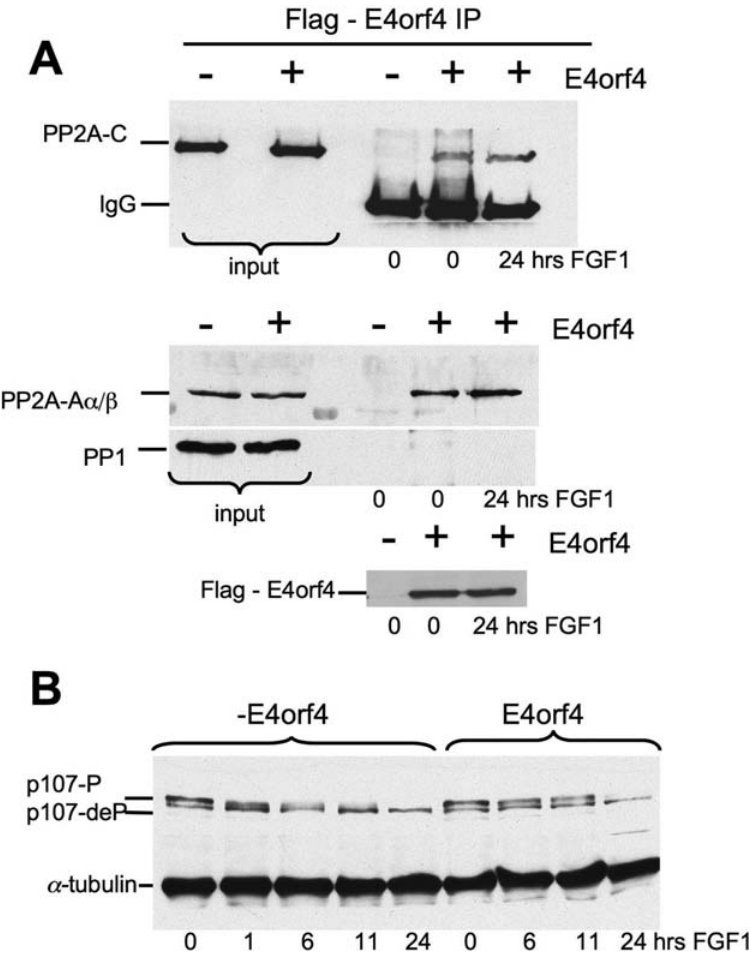
Figure 6. Expression of adenovirus E4orf4 protein strongly delays p107 dephosphorylation induced by FGF. FLAG-tag E4orf4 was stably introduced into RCS cells. Growing cultures were treated with FGF1 for indicated periods of time. (A) E4orf4 forms a stable complex with PP2A when overexpressed in RCS cells. RCS cells overexpressing FLAG-tag E4orf4 and the parental cell line were treated with FGF. E4orf4 was immunoprecipitated with ANTI-FLAG H M2-Agarose and immunoprecipitated complexes were analyzed using PP2A-A, PP2A-C or FLAG antibodies as indicated. PP1 antibody was used as a negative control. As a reference 5% of the immunoprecipitated whole cell extract (‘‘input’’) was loaded. (B) 20 m g of total protein were subjected to immunodetection by p107 antibody.